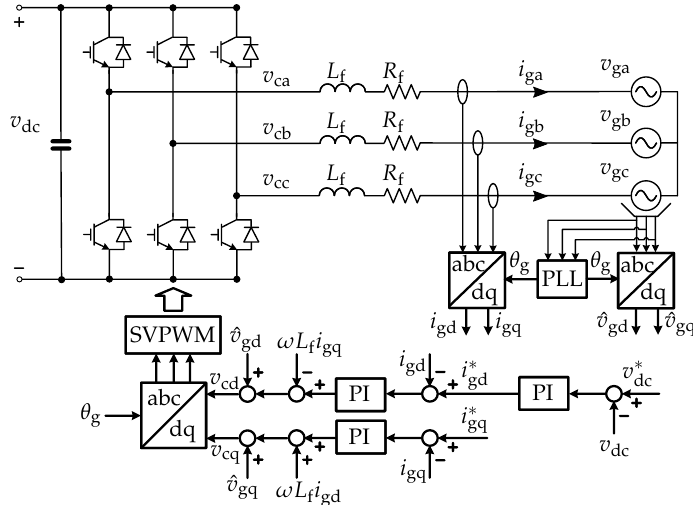
Figure 1. The classical control scheme of the transformerless three-phase grid-tied